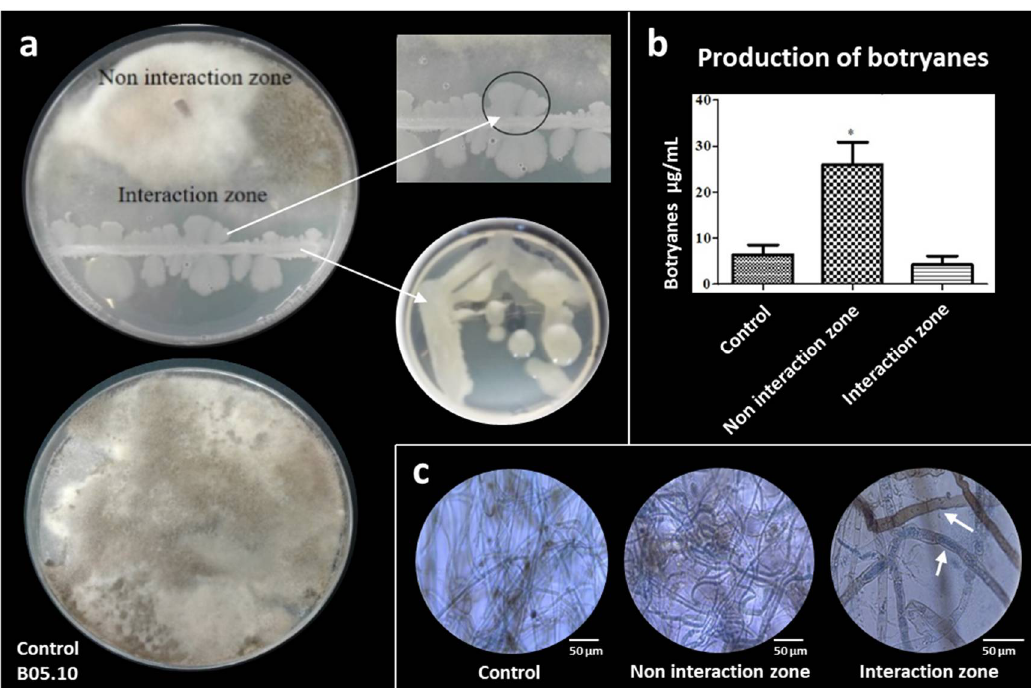
Figure 5. Co-culture of the B. subtilis 6Sm and B. cinerea B0510. ( a ) Interaction zone described as “contact inhibition”. Image shows changes in the morphology of the colony formed by B. subtilis under co-culture (black circle). Small Petri dish shows the growth of B. subtilis in axenic culture. ( b ) Production of botryanes from non-interaction zone and interaction zone, in comparison with B. cinerea B05.10 control. ( c ) Microscopical characteristics of B. cinerea B05.10 hyphae from control, non-interaction, and interaction zone. White arrows point to granulations and macrosiphonate hyphaes.